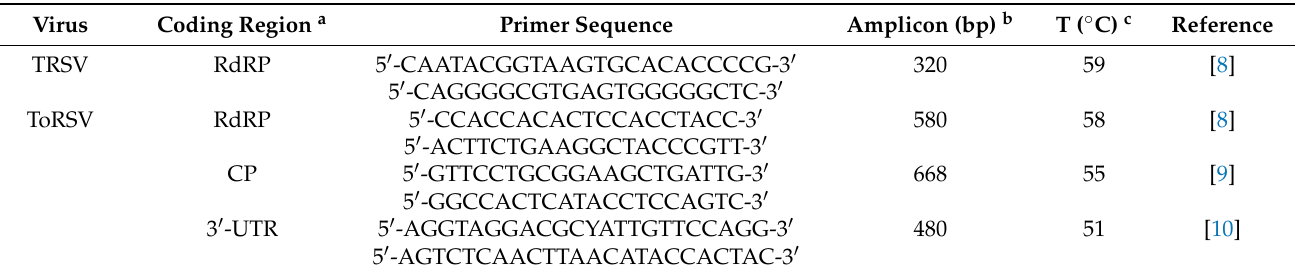
Table 2. List of diagnostic primers used to detect tobacco ringspot virus (TRSV) and tomato ringspot virus (ToRSV) by RT-PCR in pawpaw